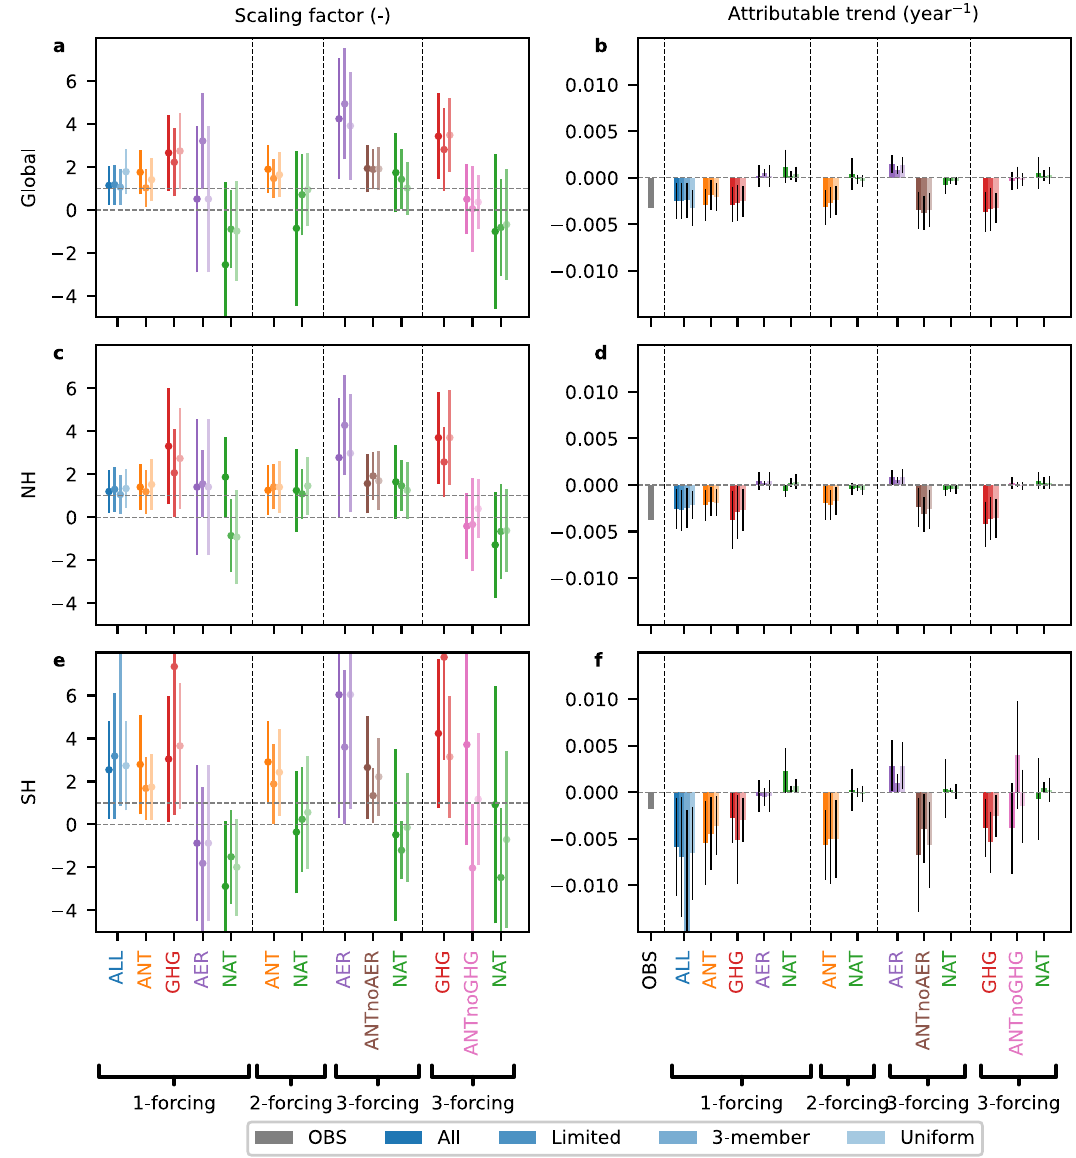
were estimated one by one (1-forcing) and jointly (2- and 3-forcing). Error bars show 90% con fi dence intervals for the scaling factors. “ ALL ” used all the available CMIP6 models, “ Limited ” used the models that have both piControl and target forcing (e.g., ALL and ANT) simulations, “ 3-member ” used models with large ensembles ( ≥ 3 members), and “ Uniform ” used models that have piControl and all the forcings (ALL, GHG, AER, NAT) simulations. The 3-member case was only displayed for the ALL forcing because it was identical to the All case for the other